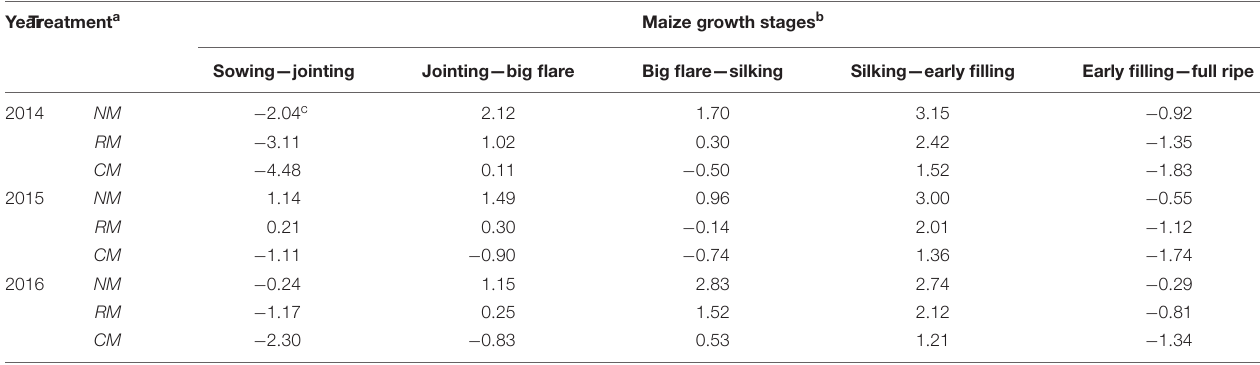
TABLE 2 | The difference value ( ◦ C) between air temperature and soil temperature in the 5- to 25-cm soil layer as affected by plastic management across the maize growth stages from 2014 to 2016 in an arid oasis region. YearTreatment